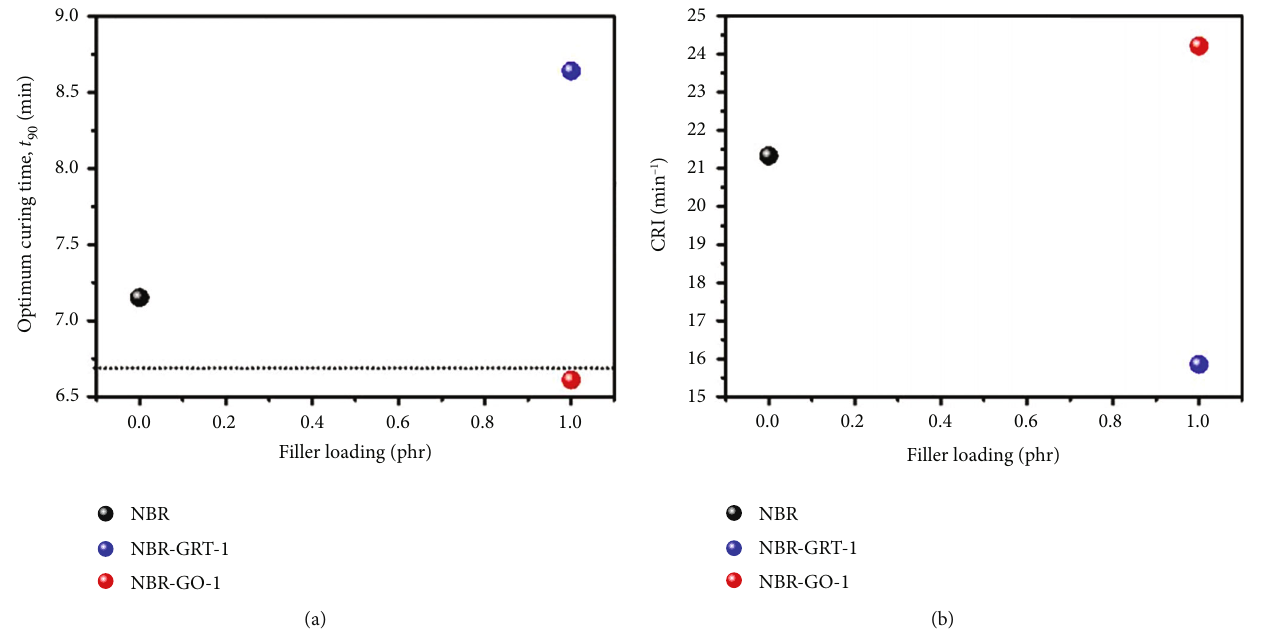
Figure 8: Cure rheometer characteristics of NBR – GO-1, NBR, and NBR – GRT-1 with optimized ZnO/SA ratio. (a) It is the cure time ( t minutes). (b) CRI (minutes – 1